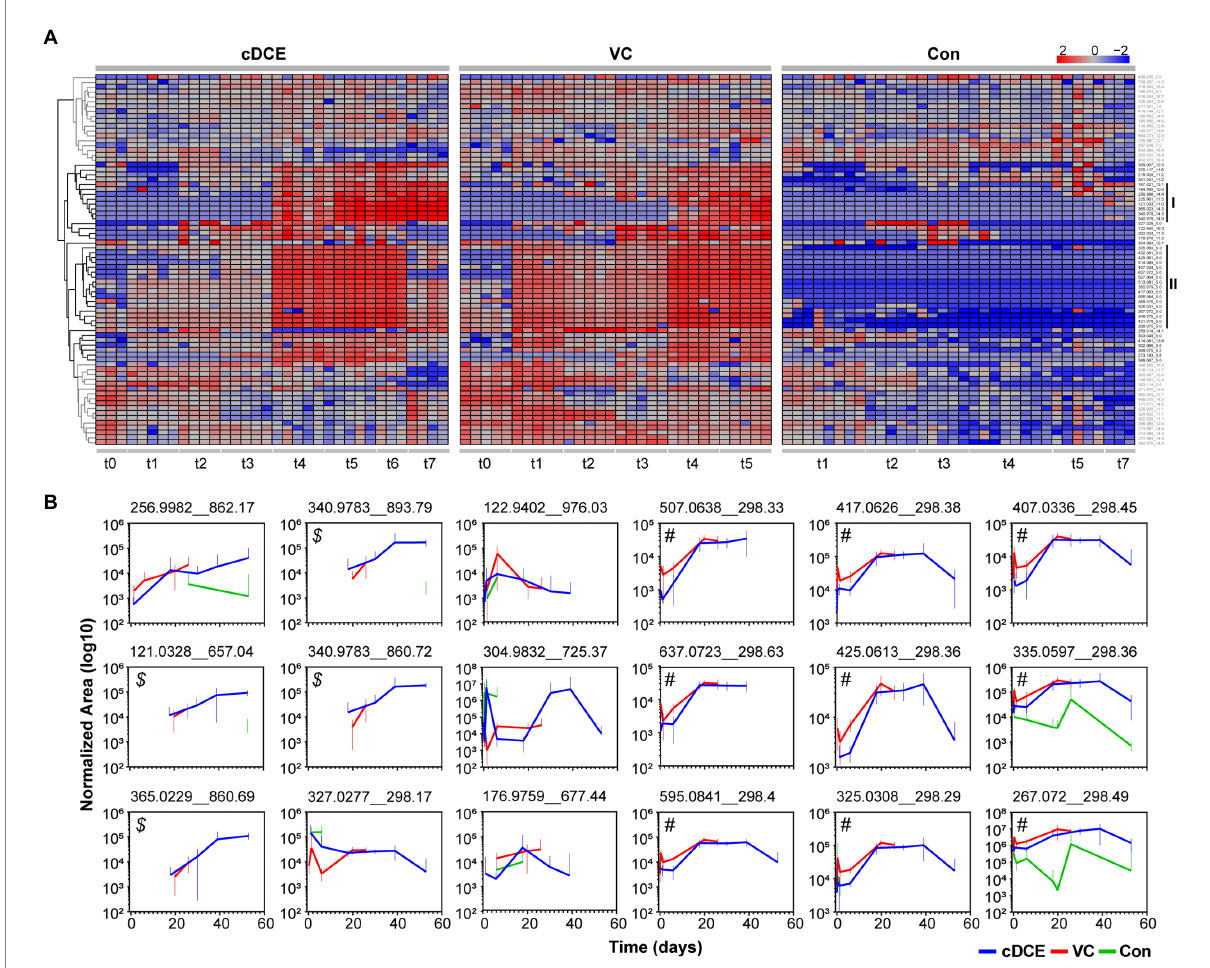
FIGURE 5 (A) Heatmap of 76 significant features determined to be significant by ANOVA analyses. (B) Temporal abundances of potential biomarkers identified from clustering analyses for cDCE, VC, and no amendment. Error bars represent 95% confidence intervals of replicate data points. Callouts ( $ and # ) are used for reference in the results and discussion